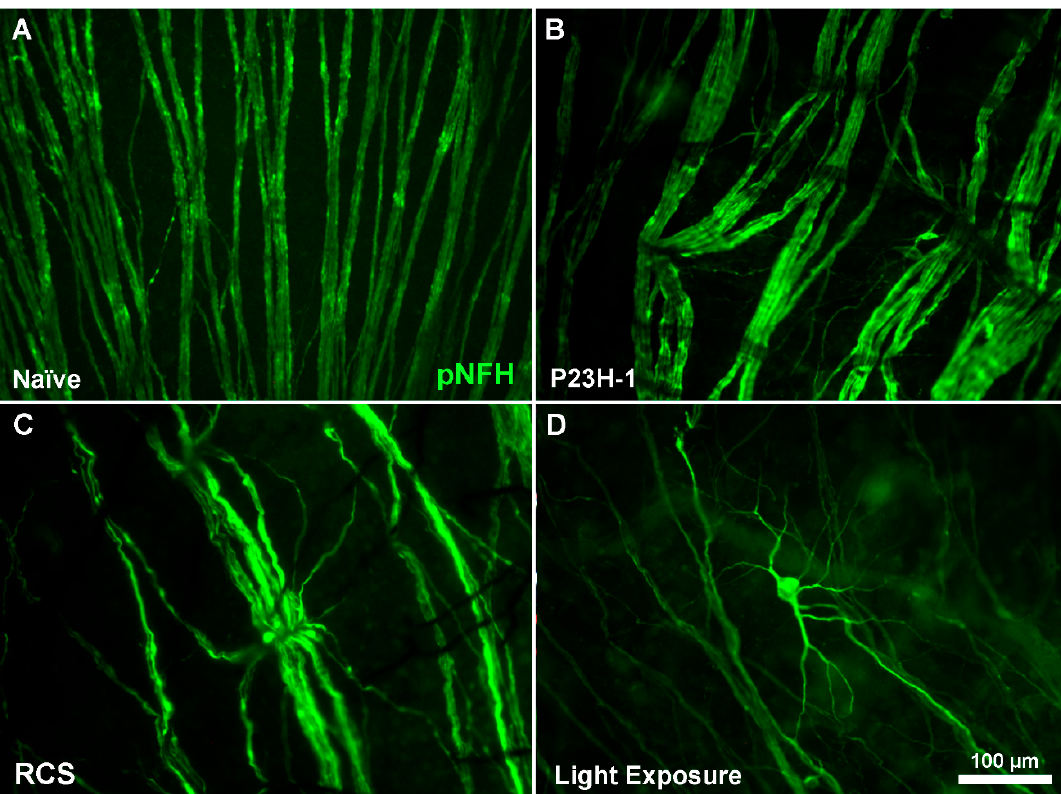
Figure 4. RGC axonal alterations. Magnifications from flat mounted retinas from a naïve SD rat ( A ), a P23H-1 rat ( B ), an RCS rat ( C ) and a light-exposed SD rat ( D ) after a complete loss of photoreceptors. RGC axons appear in green labelled with anti-neurofilament antibodies (pNFH). In the degenerating retina, the linear trajectory of RGC axons is disrupted and, in addition, some RGC bodies and their proximal dendrites appear labelled with pNFH, indicating RCG degeneration.